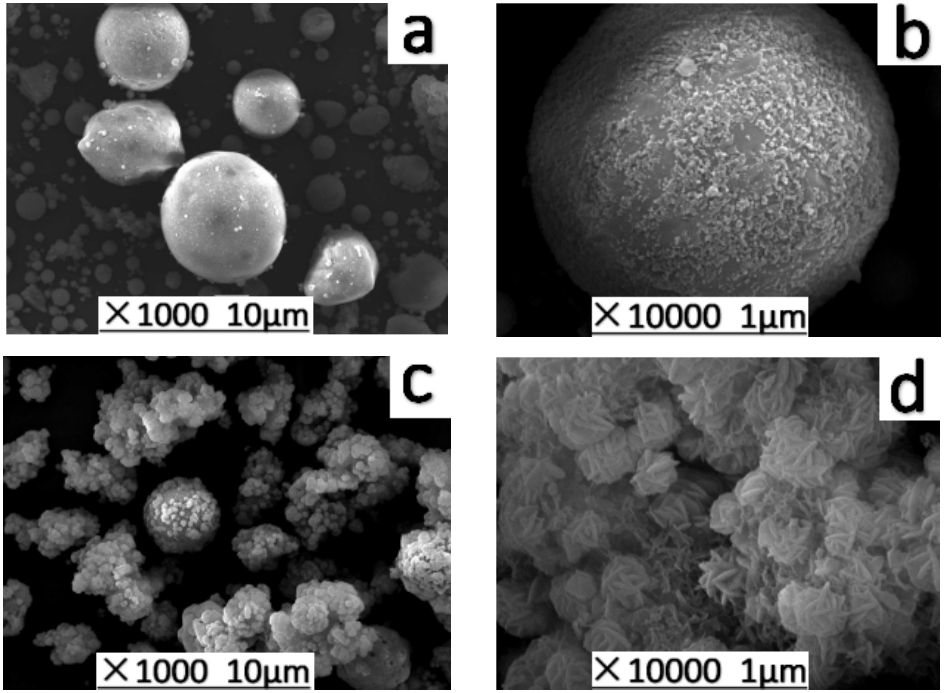
Figure 3. SEM images: ( a , b ) FA; ( c , d ) SOD.